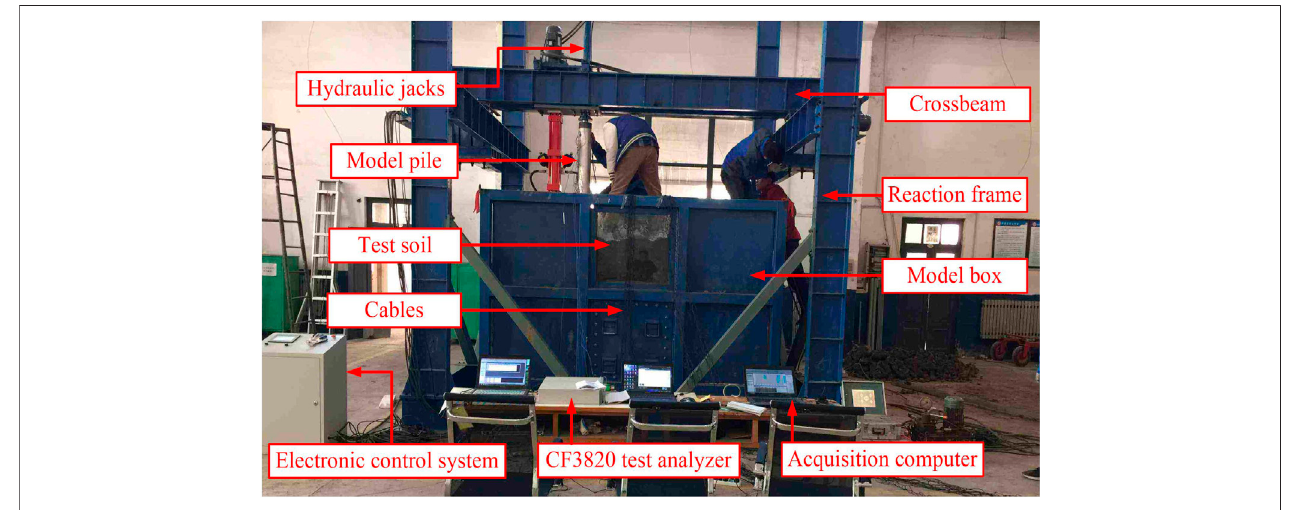
FIGURE 5 | The composition of the test system.